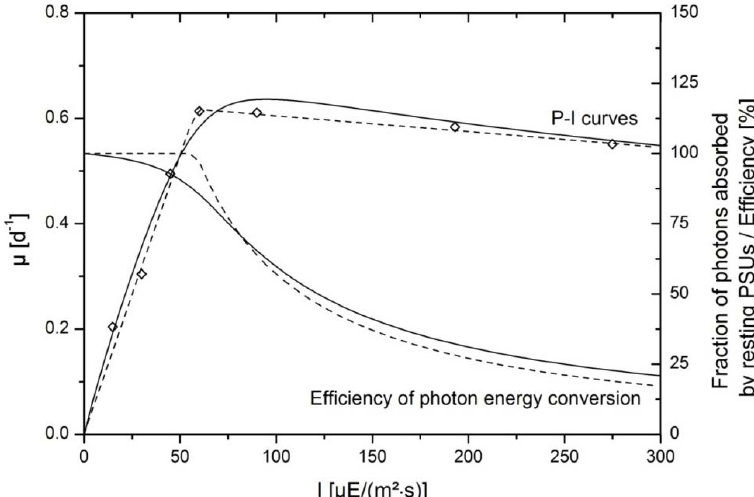
Figure 2. Efficiency of photon energy conversion in the photosynthetic system of P. tricornutum . Continuous lines indicate data fits according to the model published by Camacho Rubio et al. [22]. Interrupted lines represent the growth curve in dependence of light intensity and efficiency of photon capture with the piecewise linear data fit. Experimental data are shown with symbols. I indicates the incident photon flux density; and µ is the growth rate of the